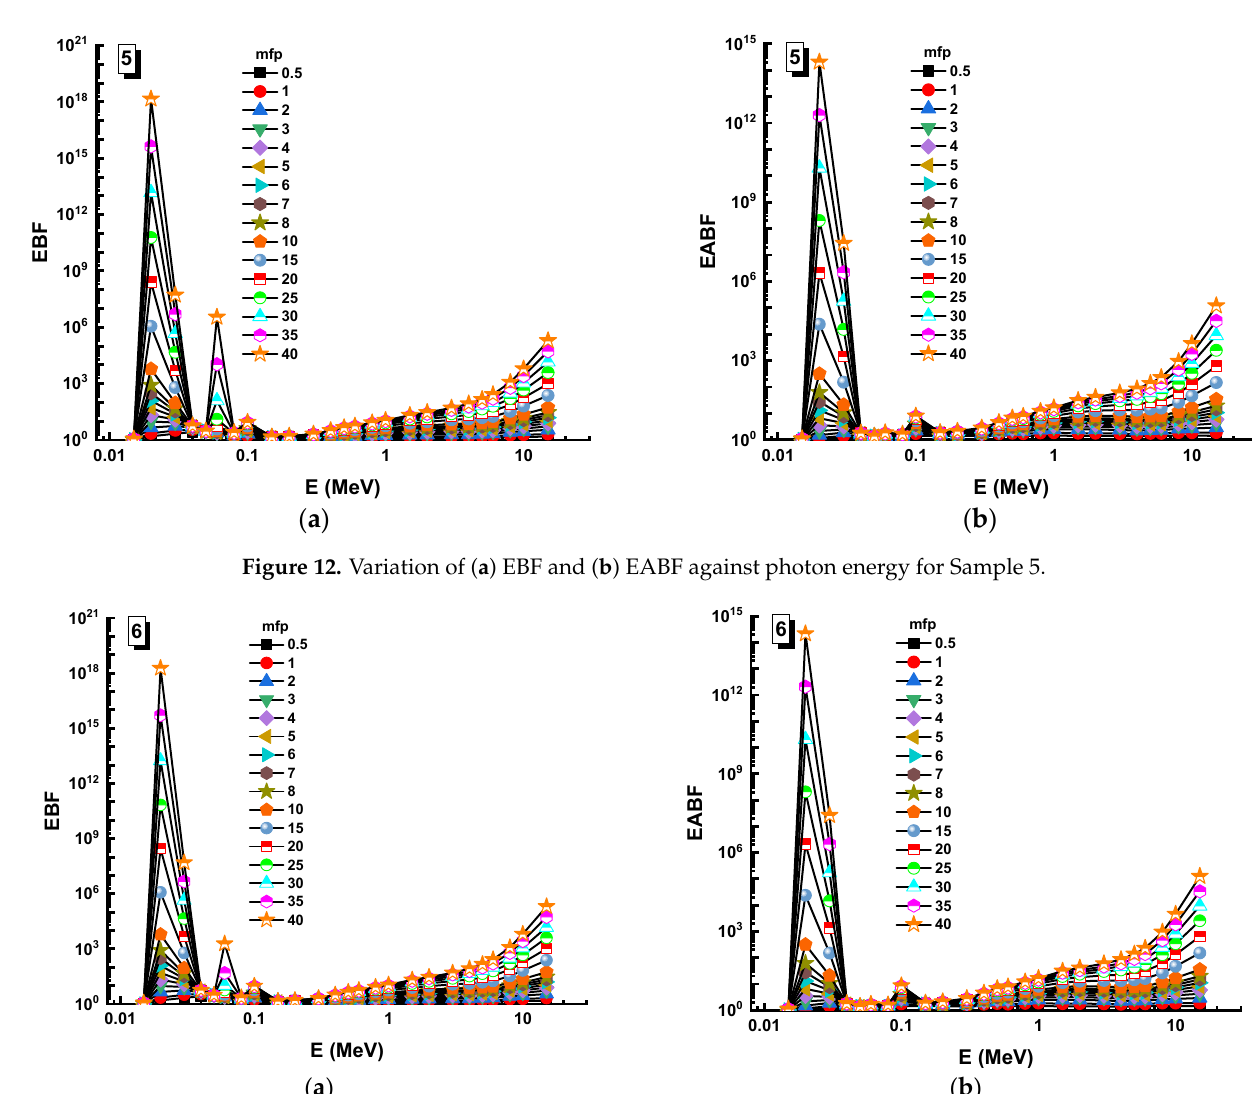
Figure 13. Variation of ( a ) EBF and ( b ) EABF against photon energy for Sample 6.